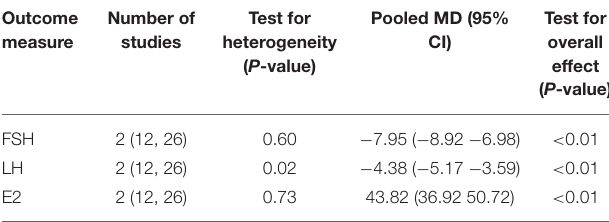
TABLE 2 | Meta-analysis of serum sex hormones change between HIFU and MYO.